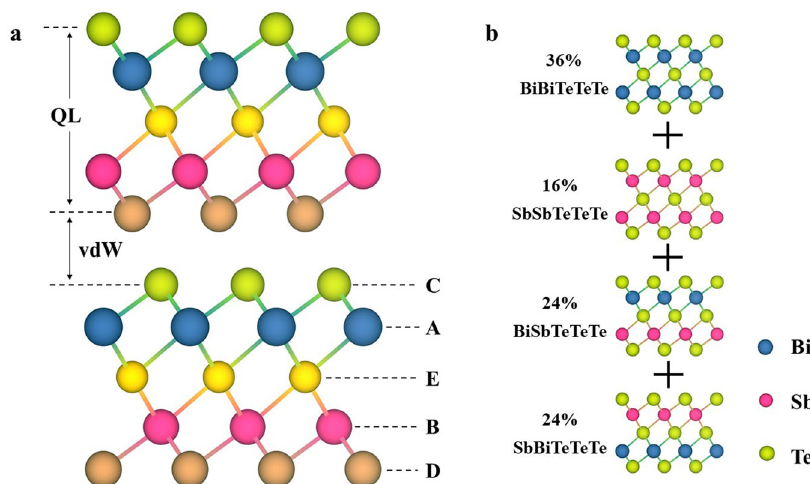
Fig. 1 Crystal structures. a The tetradymite compounds can be viewed as quintuple layers (QLs) held together by van der Waals (vdW) forces, where fi ve atomic sites (A, B, C, D, E) are marked. b Four con fi gurations and their mole contents for the ternary tetradymite Bi 1 : 2 Sb 0 : 8 Te 3 .